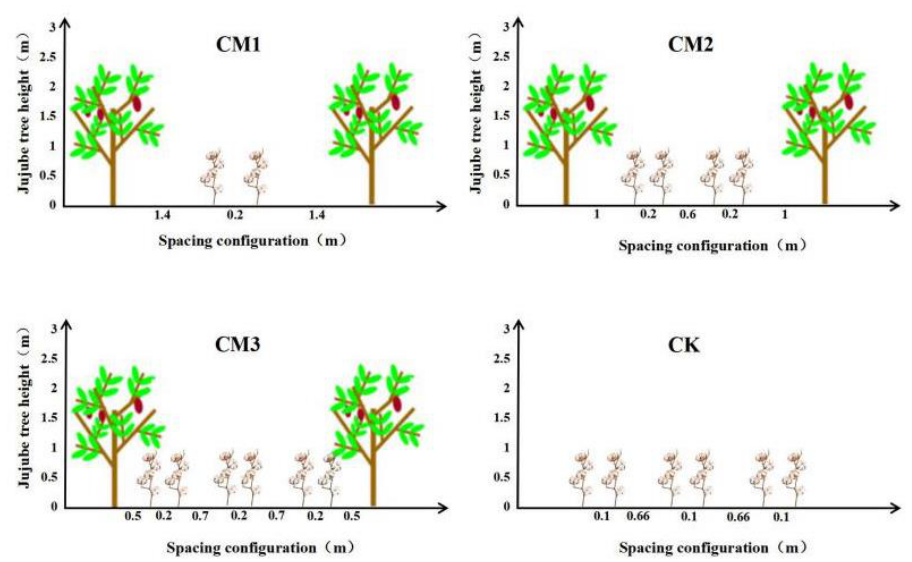
Figure 3. Diagram of field configuration modes.